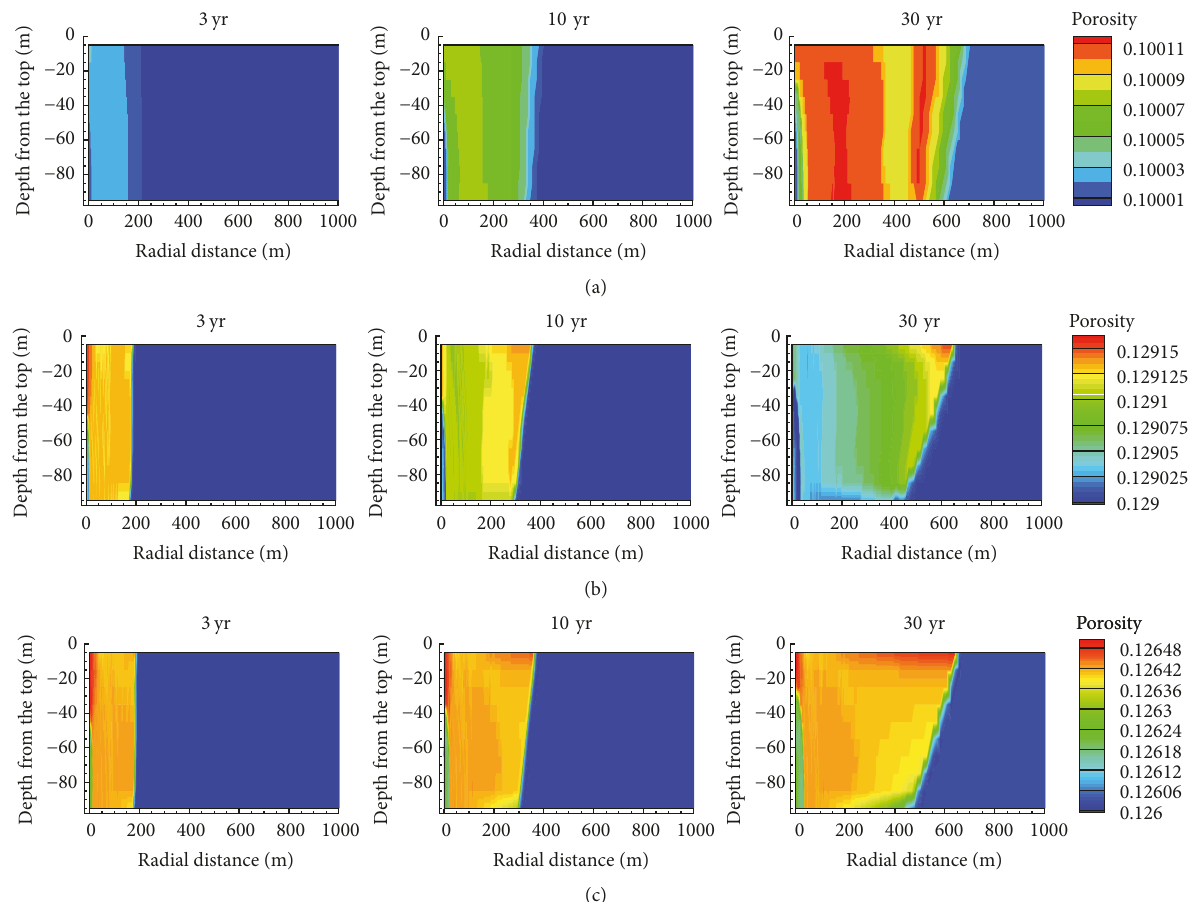
Figure 6: The evolution of porosity in the three formations ((a): Liujiagou formation; (b): Shiqianfeng formation; (c): Shihezi formation).